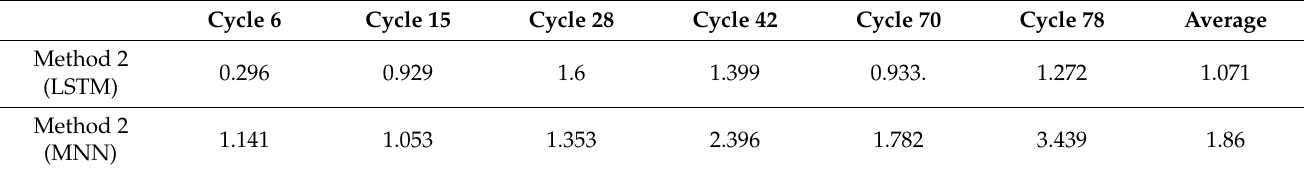
Table 5. SOH estimation error for each model using the Oxford battery dataset.